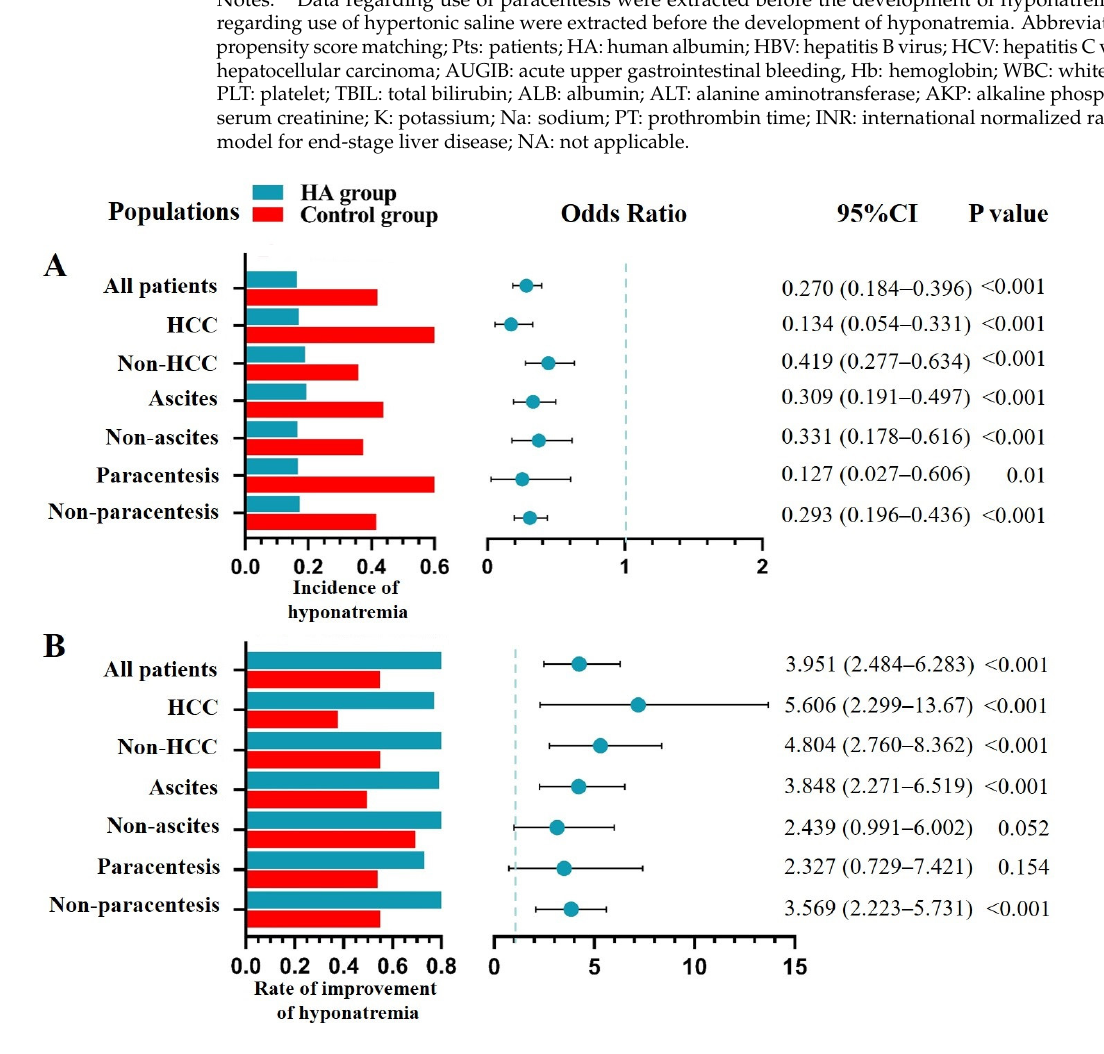
Figure 2. HA infusion for the prevention and treatment of hyponatremia during hospitalizations. ( Panel A ): Bar plots displayed the incidence of hyponatremia in the HA and control groups, and forest plots showed the ORs with 95%CIs for the role of HA infusion for the prevention of hyponatremia. ( Panel B ): Bar plots displayed the rate of improvement of hyponatremia in the HA and control groups, and forest plots showed the ORs with 95%CIs for the role of HA infusion for the improvement of hyponatremia. Abbreviations: HA: human albumin; CI: confidence intervals; HCC: hepatocellular carcinoma.